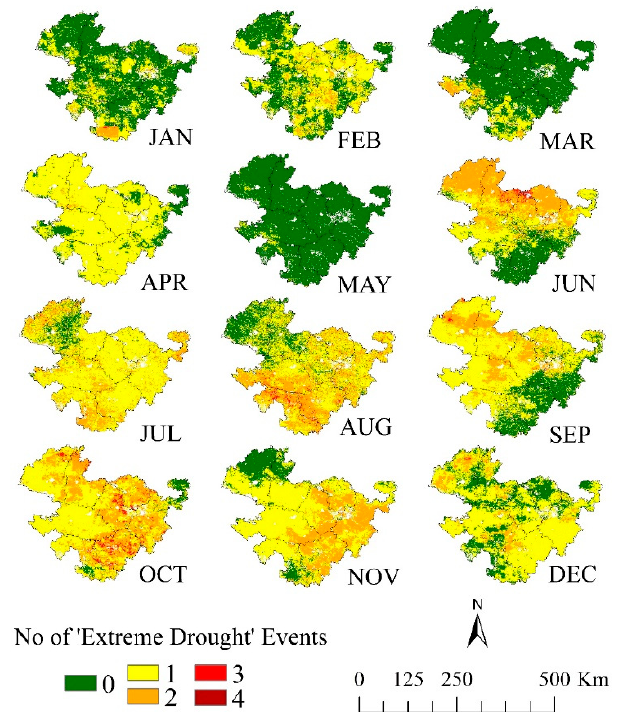
Figure A1. Spatio-temporal representation of Method-II-based number of ‘extreme drought’ events that occurred between 2001 to 2018.